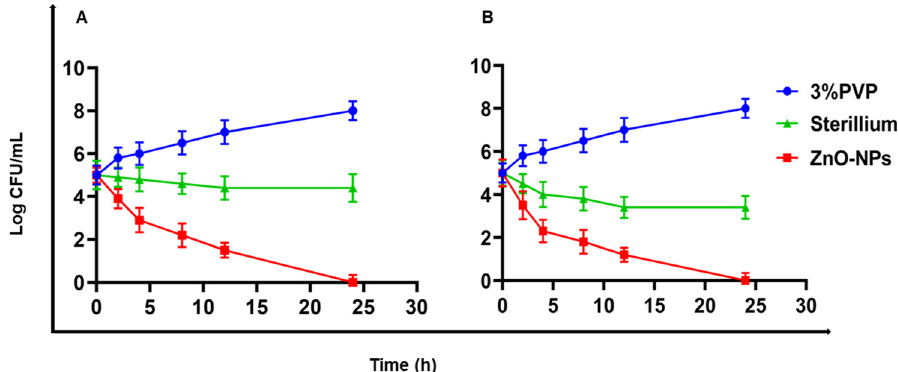
Figure 5. Time–kill curve of antibacterial activity of the ZnO-NPs and Sterillium at their MIC value against ( A ) MRSA and ( B ) A. baumannii . Each time point is the average of two independent experiments with three replicates each. Error bars represent standard deviation.